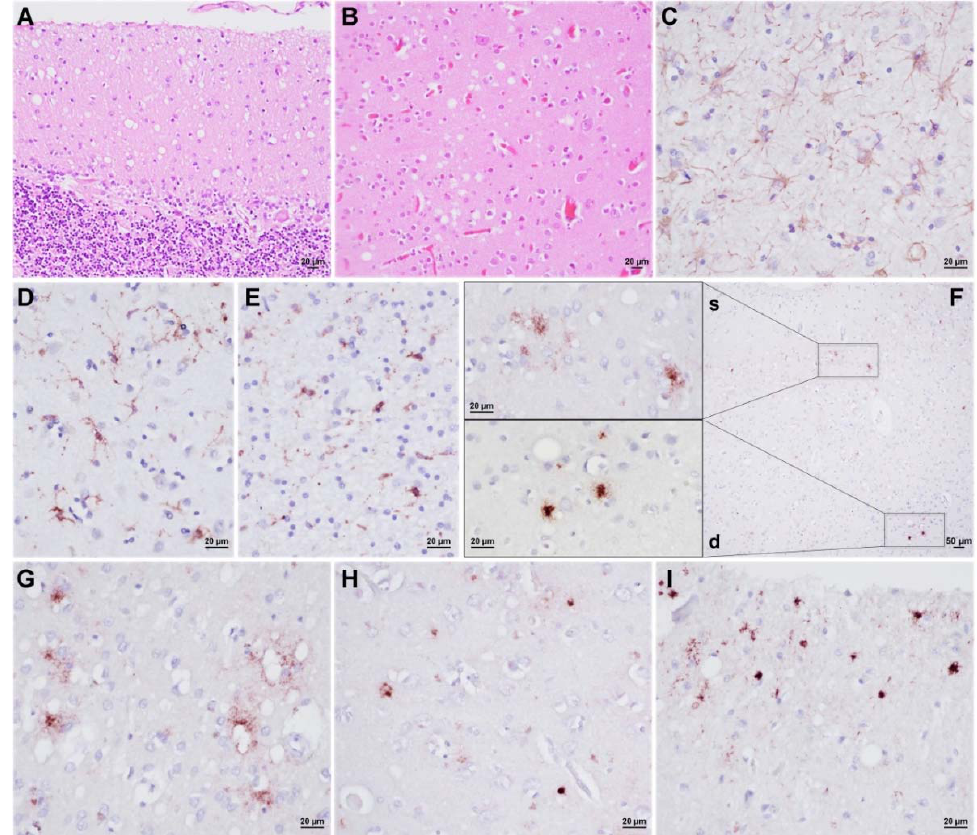
Figure 1. Neuropathological features of VPSPr 129MM (Case#1). ( A , B ) Spongiform change with vacuoles of “intermediate” size in the cerebellum molecular layer and occipital cortex. ( C ) Activated astrocytes in the occipital cortex. ( D , E ) Marked microglial activation involving both the occipital gray and white matter. ( F ) PrP deposits in the occipital cortex: on the left, the upper left box shows delicate, patchy granular PrP deposits in the superficial cortical layers, while the lower box small plaque-like PrP deposits in the deep layers. ( G ) Granular PrP deposits surrounding the vacuoles (occipital cortex). ( H , I ) Small plaque-like PrP deposits in the entorhinal cortex and cerebellar molecular layer. Haematoxylin-eosin staining ( A , B ), and immunochemistry for GFAP ( C ), HLA ( D , E ), and PrP ( F – I ). Legend: s, superficial; d, deep.